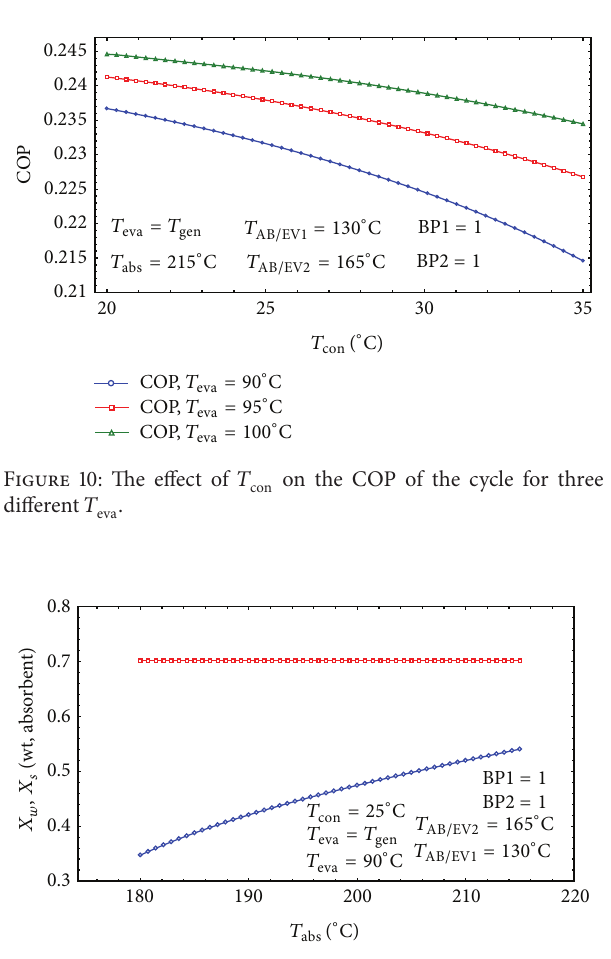
on COP of the AB / EV 1